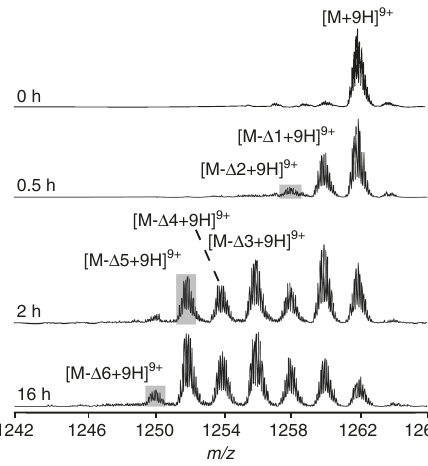
Fig. 4 AMdnC processes AMdnA in a distributive manner. HR-MS analysis showed the formation of intermediates with varying degrees of dehydrations after incubating AMdnA with AMdnC for 0, 0.5, 2, and 16 h. The molar ratio of substrate/enzyme was set to 115:1 to assist the detection of accumulated